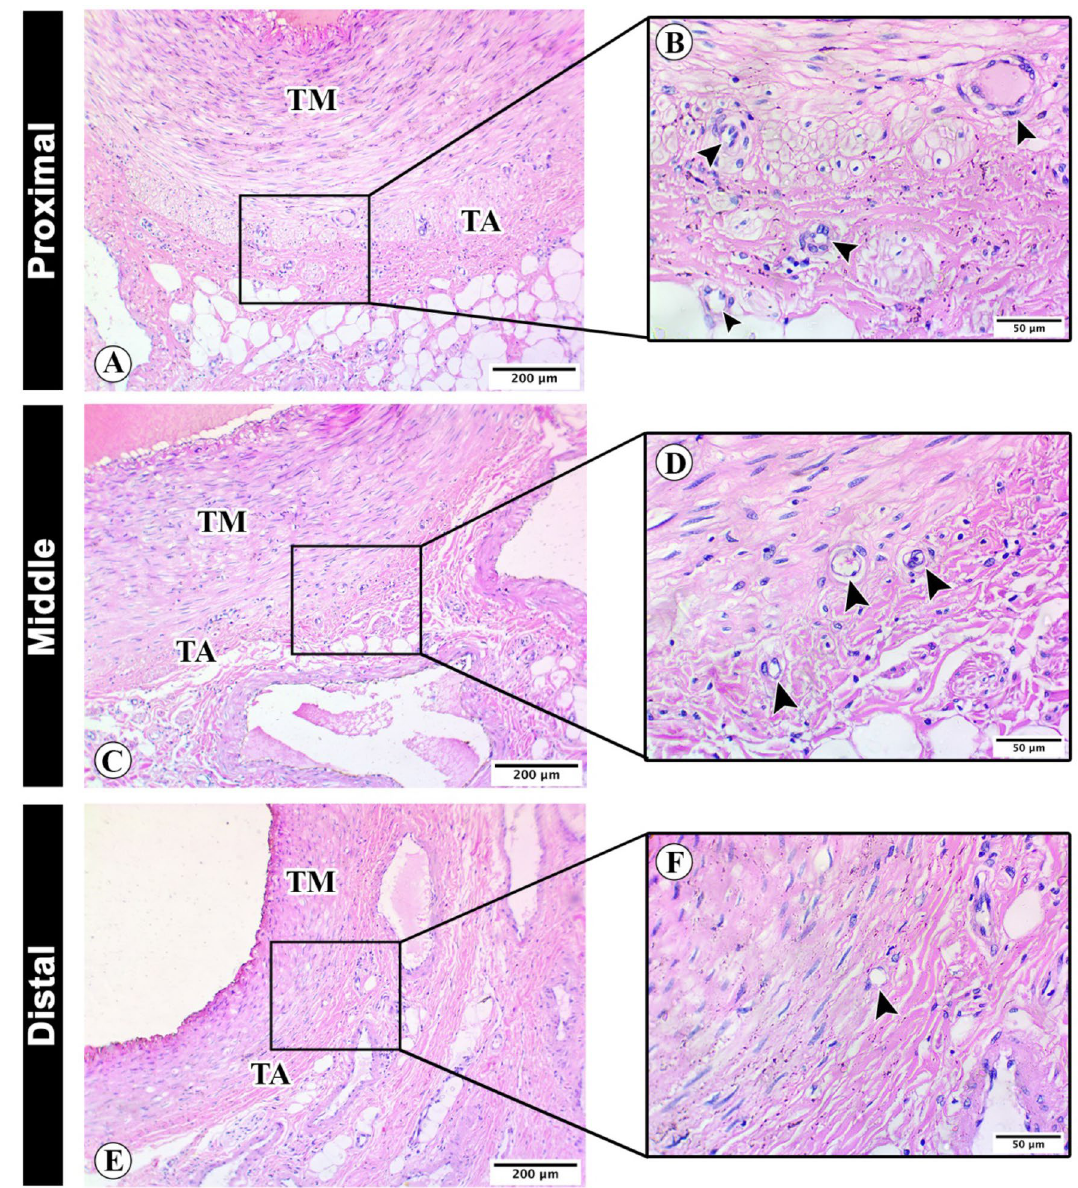
stained by H&E showing vasa vasorum (arrowheads). tunica media (TM) and tunica adventitia (TA). ( A , C , E ): bar 200 µm and ( B , D , F ): bar 50